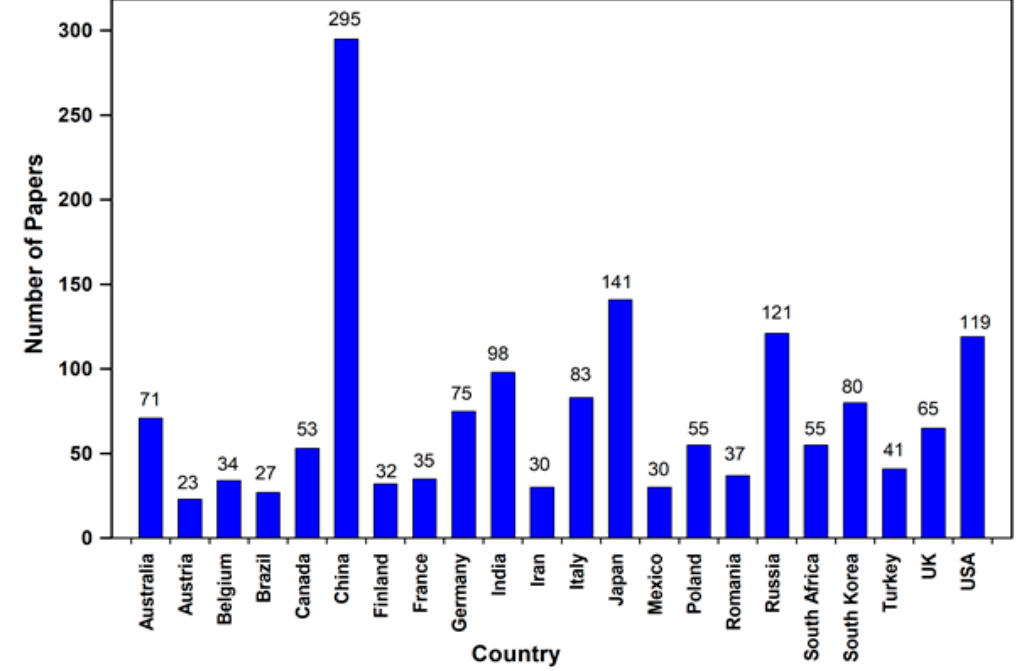
Figure 2. Breakdown by country of the research trends in the processing of secondary resources from publications in Figure 1. (Source: Scopus. The same information obtained for Figure 1 was used, and the country breakdown was limited to countries with 20 or more published articles on the recovery of precious metals from spent secondary products and